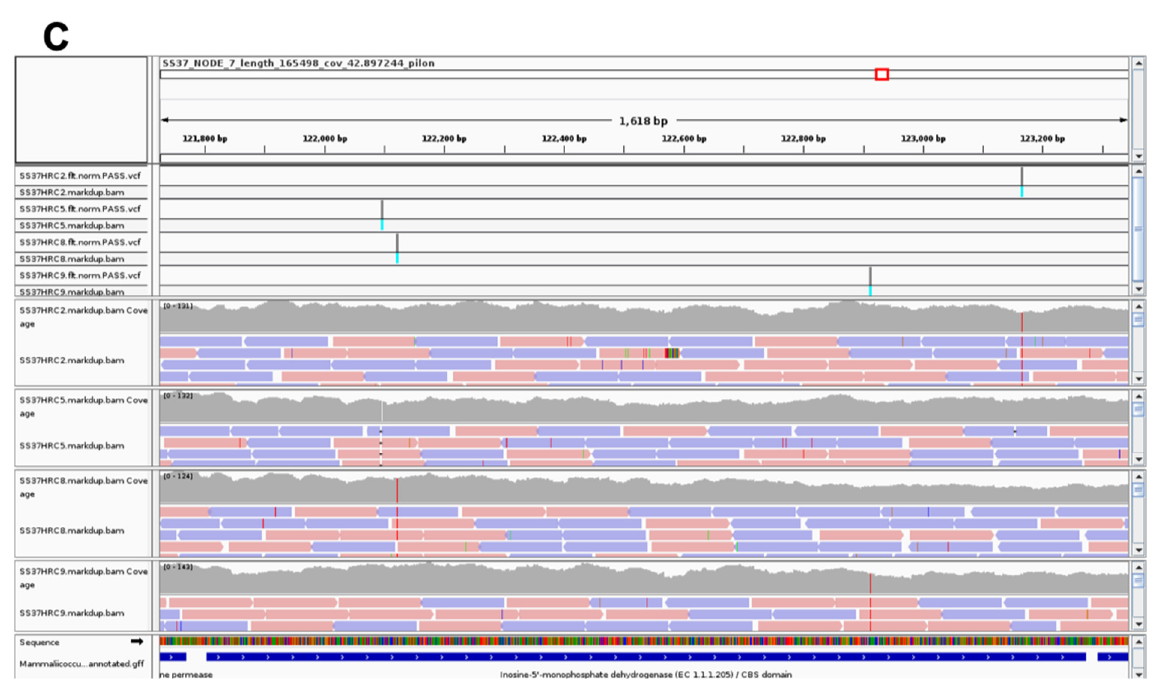
Figure 2. Overview of the mutations found in genes related to guanine metabolism: ( A ) hpt in LGA251HRC2 and LGA251HRC5; ( B ) relA2 in RUSA239HRC4; ( C ) guaB in SS37HRC2, SS37HRC5, SS37HRC8, and SS37HRC9. Mutations are shown as grey bars.